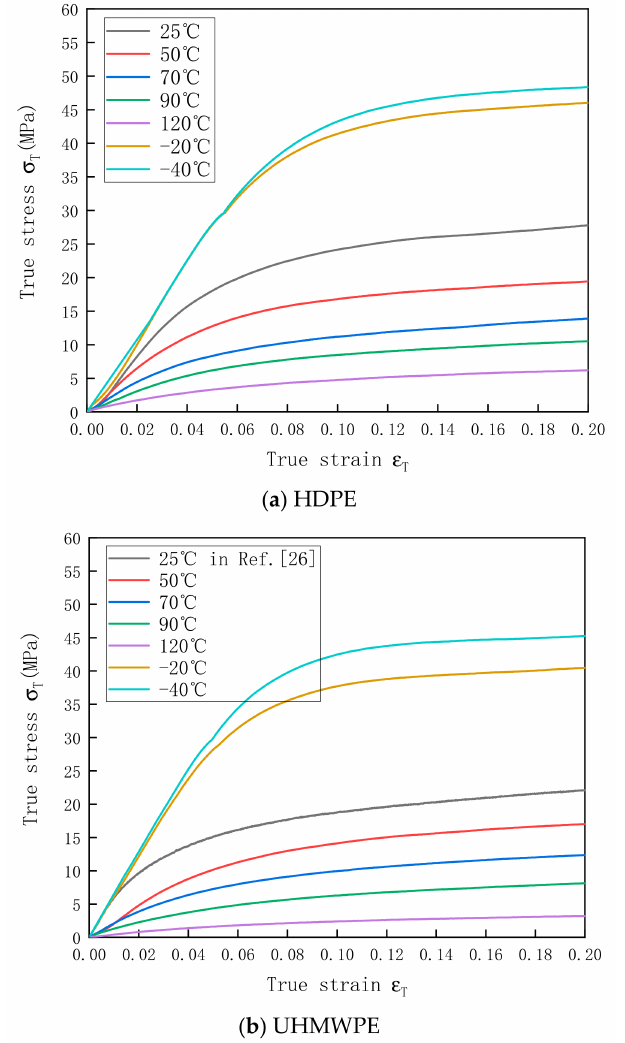
Figure 6. Stress–strain curves of ( a ) HDPE and ( b ) UHMWPE at a strain rate of 0.001 s − 1 and temperatures of − 40–120 ◦